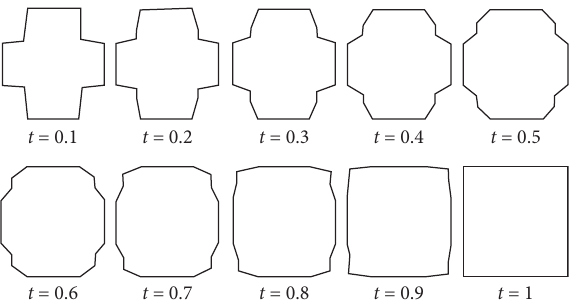
Figure 3: Schematic diagram of feature point selection.